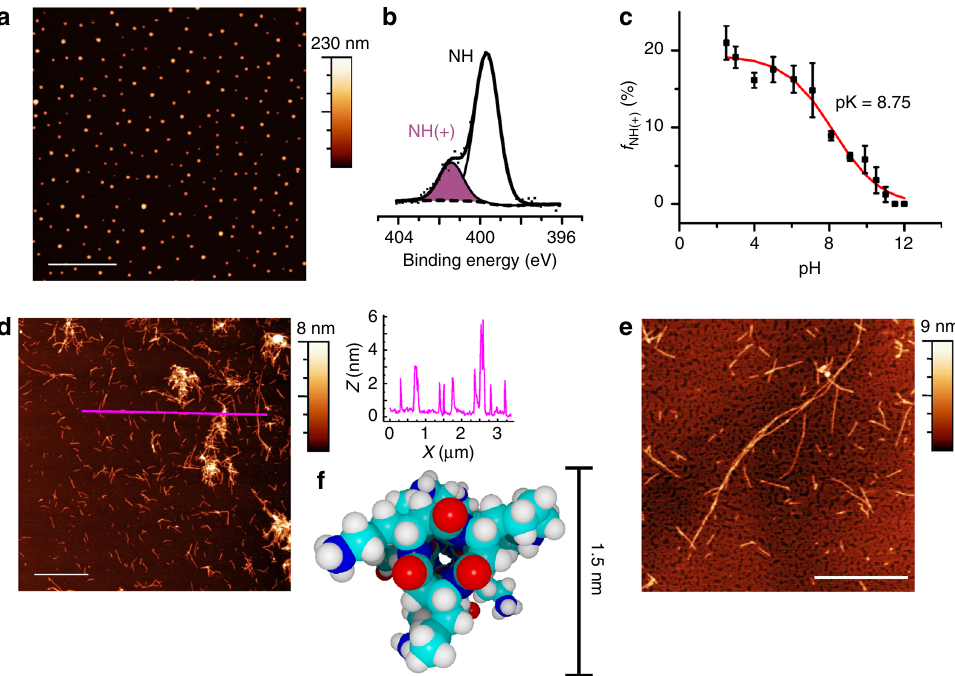
Fig. 3 pH response of the cyclic β -tripeptide polymer. a AFM image (5 µ m scale bar) of polymer deposited on mica from a 1 mgmL − 1 solution in 0.1 M acetic acid (pH = 2.9). Color bar indicates the Z heights in the images, with the baseline (black) set to 0 nm. b N 1s XPS spectrum collected from the polymer- coated substrate shown in ( a ). c Fraction of protonated amino groups ( f NH( + ) ), as determined by XPS, in thick polymer fi lms deposited on gold from 0.1 M sodium phosphate buffers with pHs ranging from of 2.5 – 12.0. Data points (mean ±SD; N = 3) are fi t to a sigmoid curve (see Methods section) 28 , to determine the pK. AFM images of the polymer deposited on ( d ) mica (1 µ m scale bar) and ( e ) graphite (500 nm scale bar) from a 1.0mgmL − 1 aqueous solution after NH 4 OH vapor diffusion (pH ≈ 11); height pro fi le along the magenta line is shown to the right ( d ). f Cross-sectional view of a molecular model of the synthesized cyclic β -tripeptide polymer